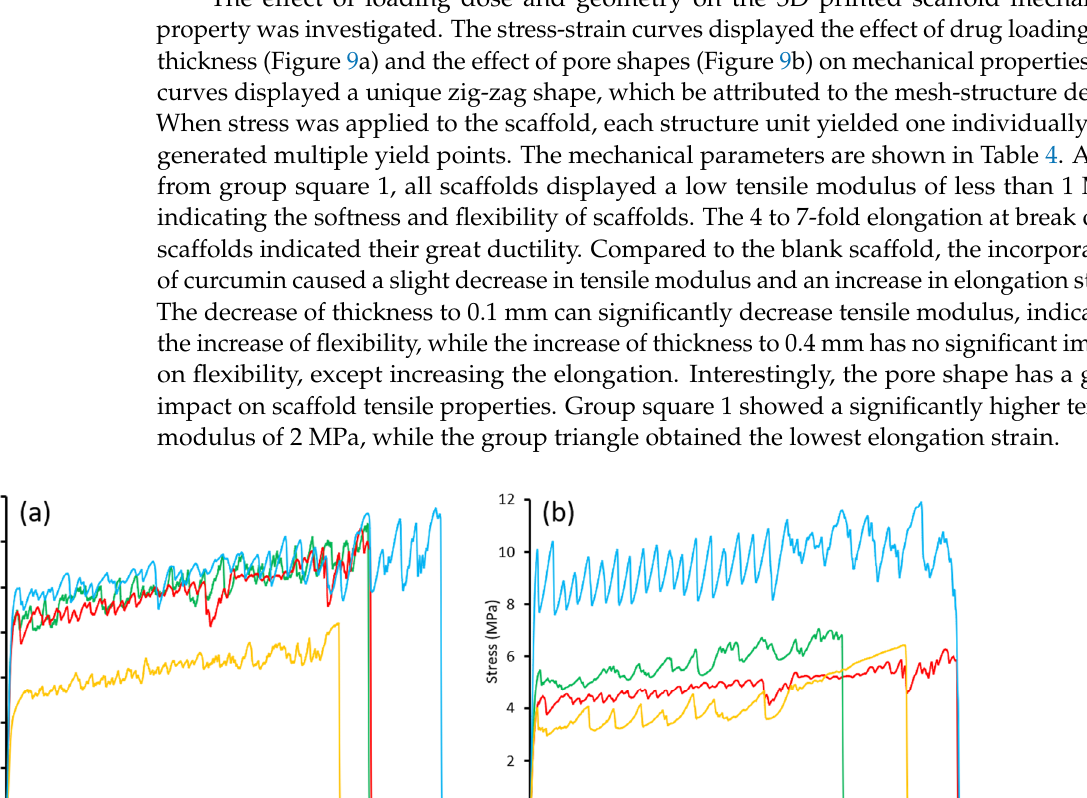
Table 4. Mechanical parameters of the blank honeycomb scaffold, 7% ( w / w ) honeycomb scaffolds with thickness 0.1, 0.2, and 0.4 mm; 7% ( w / w ) triangle, square 1, and square 2 scaffolds with thick- ness 0.2 mm ( n = 5 per group). Figure 9. Stress-strain curves of 3D printed scaffolds showing ( a ) the effect of dose and thickness ( b ) the effect of pore shapes. Compared to the stiff polymer matrix of GLIADEL wafer, polyanhydride, which has a high tensile modulus of 3000–5000 Mpa [43], PCL scaffold has a much lower tensile modulus of less than 2 MPa and its flexibility is shown in Figure 10. Thus, 3D printed PCL scaffold obtained great flexibility and stretchability as a soft implant for brain application and the mechanical properties can be easily altered by 3D printing. In the clinic, the scaffold can be printed based on individual tumour size; after resection, the surgeon can tenuously tailor the scaffold to perfectly match the size and shape of the tumour cavity, then attach it to the cavity margin with suturing to eradicate residual tumour cells